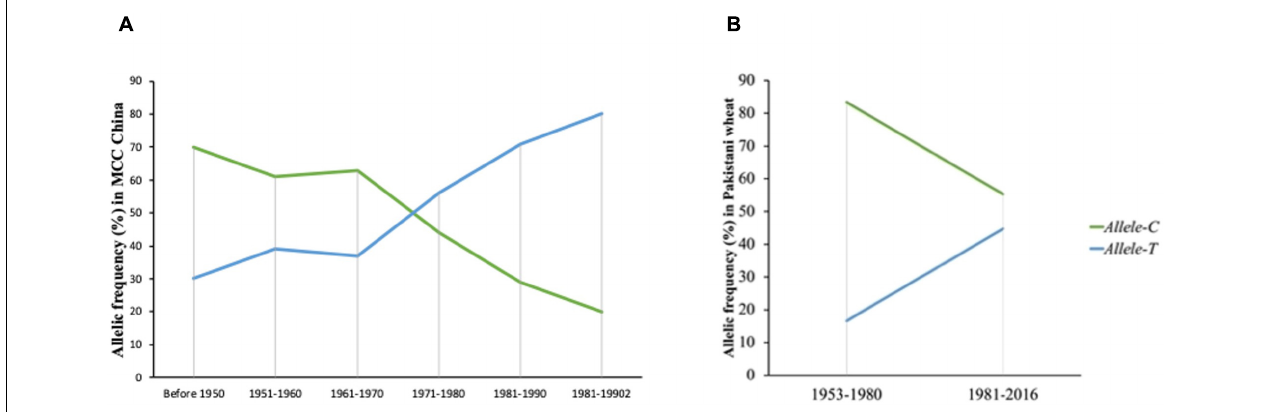
FIGURE 7 | Selection of favored allele of TaSBEIII-A in wheat breeding history of China and Pakistan. (A) The frequency of China accessions. (B) The frequency of Pakistan accessions.